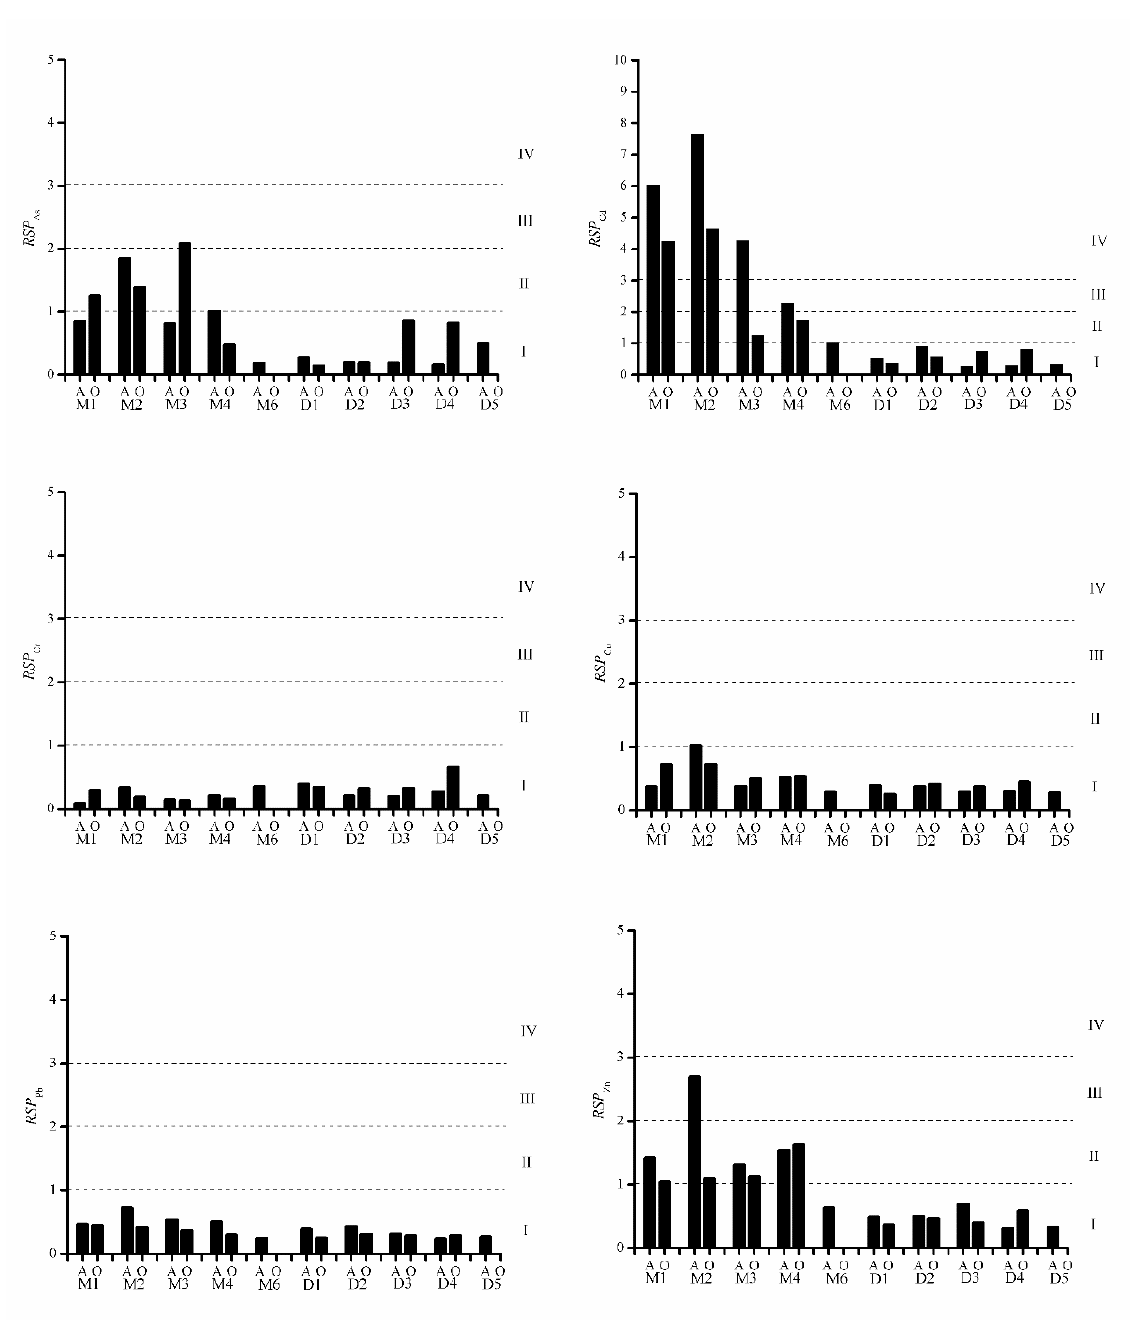
Figure 4. Ratio of secondary phase and primary phase (RSP) of heavy metals in Manwan (M) and Dachaoshan (D) cascading dams. A = dry season, April 2016. O = rainy season, October 2016.